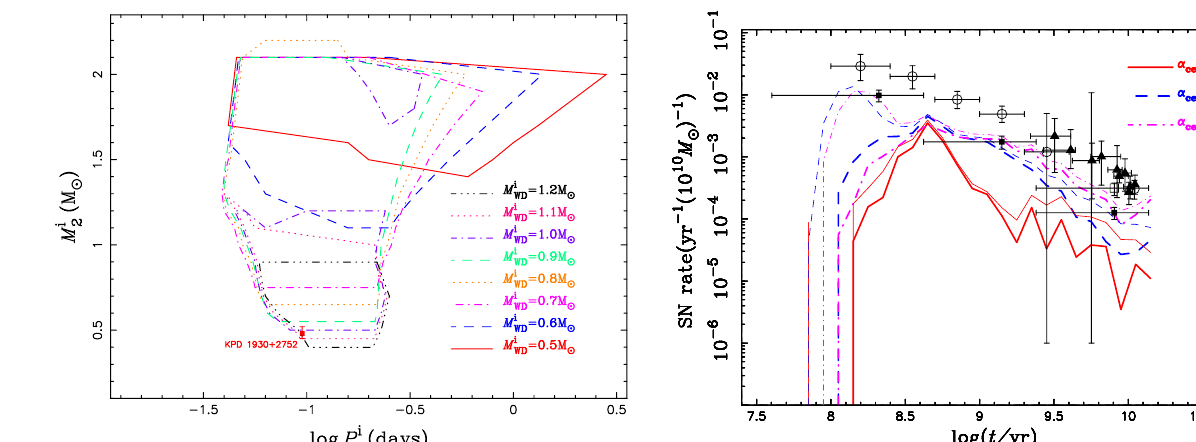
Figure1showstheparameterspaceofWD+Hestarsys-